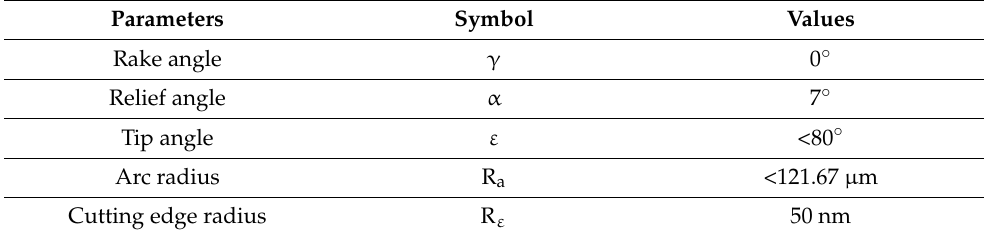
Table 2. Geometric parameters of the utilized diamond tool.